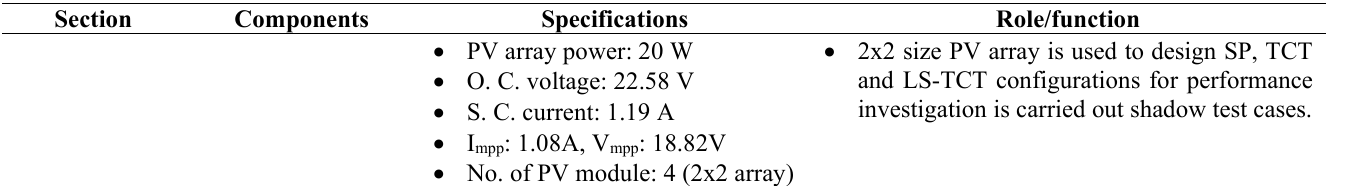
Table 1. Specifications and role of supportive items used in developed experimental